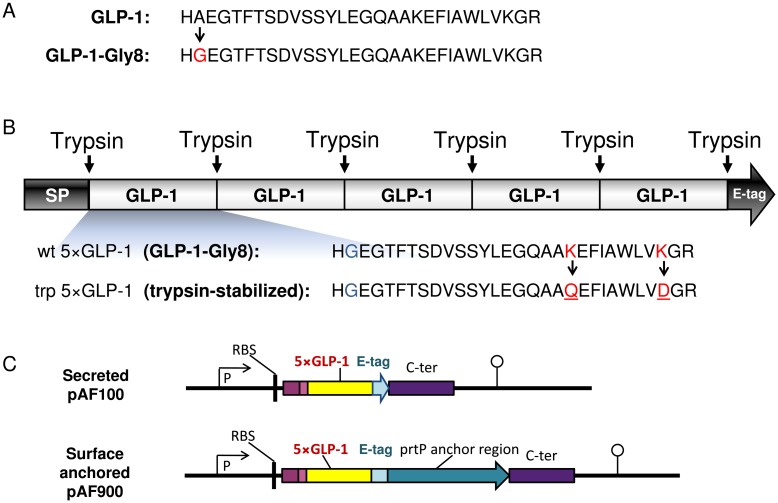
Design of GLP-1 analogues (A), pentameric GLP-1 (B) and expression cassettes for 5×GLP-1 delivery by L. paracasei (C).SP, signal peptide; RBS, ribosomal binding site; P, apf promoter; C-ter: C-terminal part of APF gene; prtP anchor translational stop codon (indicated with an arrowhead) and the transcription terminator (indicated with a lollipop).